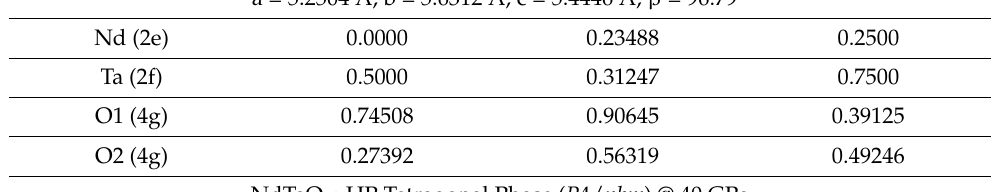
Table 2. Calculated structural parameters along with the atomic positions of NdTaO 4 and SmTaO 4 at ambient pressure and transition